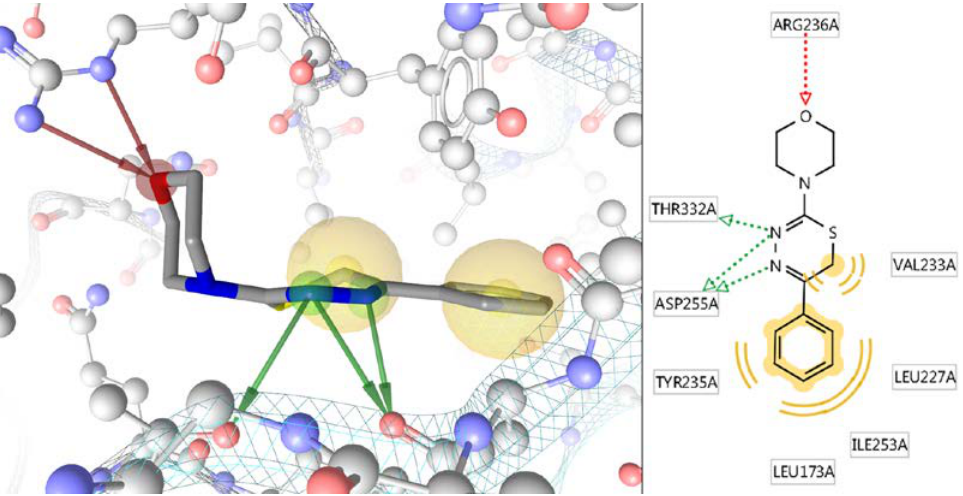
Figure 2. Molecular mechanism of binding of the L-17 molecule to the AKT1 kinase site.